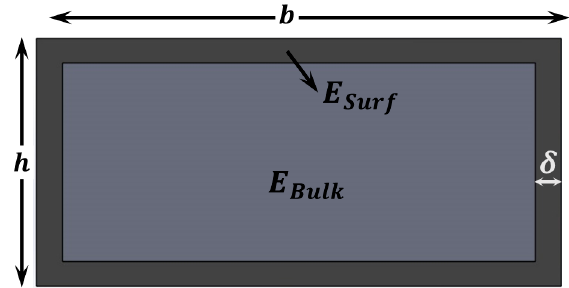
Figure 4. Surface Elasticity Theory (SET). Schematic showing the cross section of a layer that shows different material properties close to the surface. This can be caused either by fundamental atomic-level differences (different coordination number) or by collateral effects during